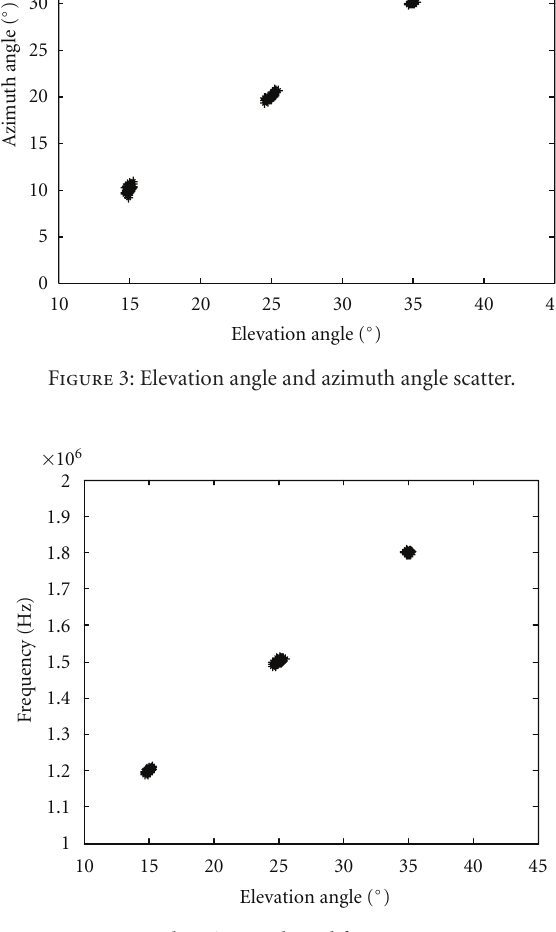
Figure 4: Elevation angle and frequency